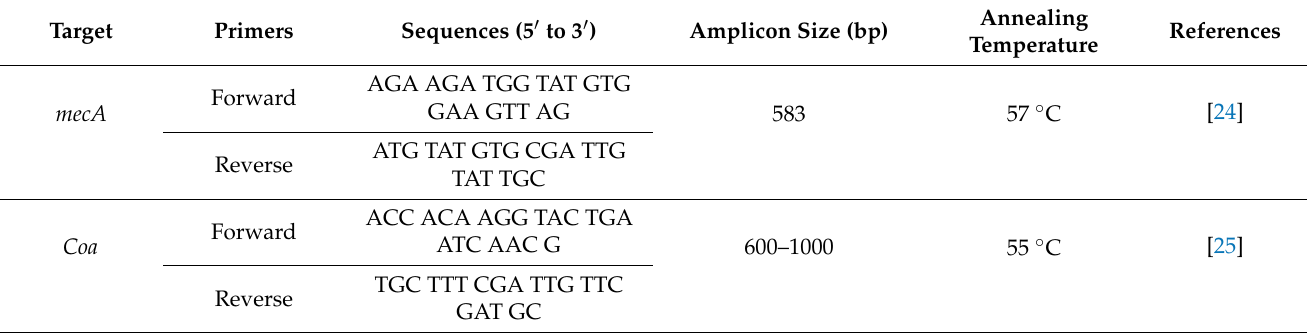
Table 1. PCR primers and conditions for coa and mec A gene